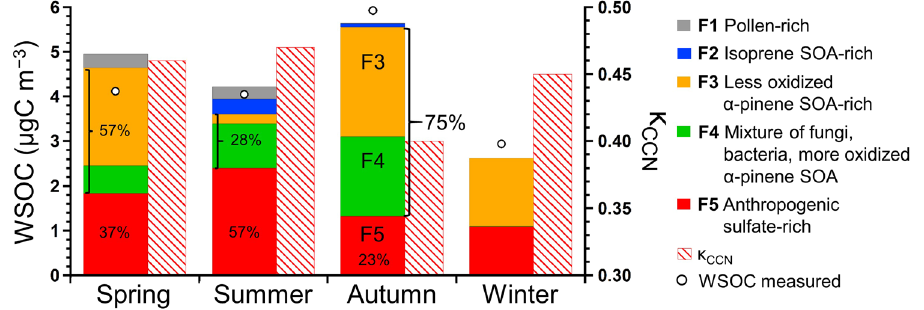
Figure 4. Contribution of each PMF-derived factor to the WSOC mass concentration and the average κ CCN in each season. Open circles indicate the average mass concentrations of the measured